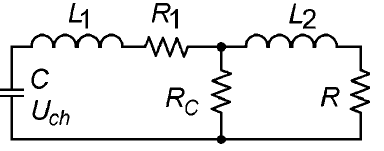
FIG. 10. Equivalent electrical circuit of a fast LTD stage.